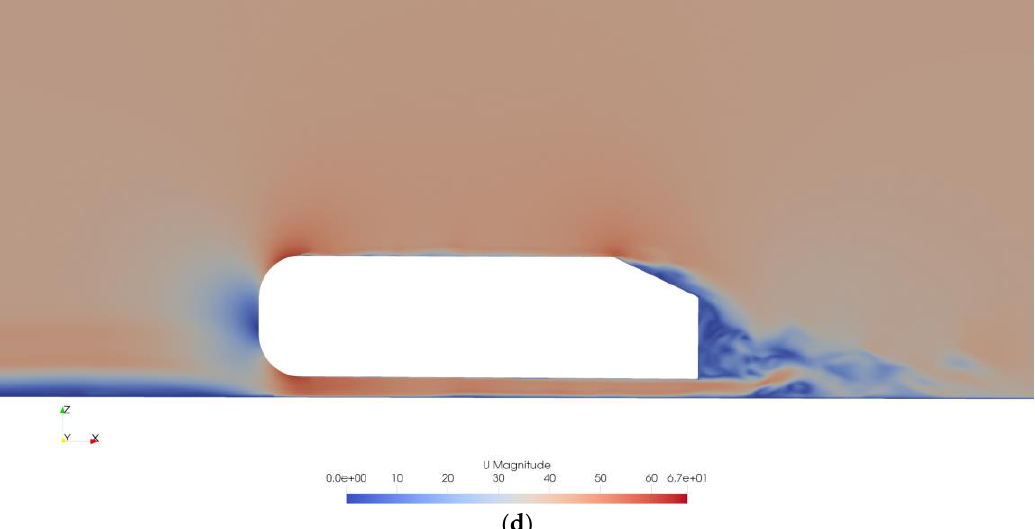
Figure 11. Velocity contours for ( a ) RANS; ( b ) URANS; ( c ) VLES steady; ( d ) VLES simulations.